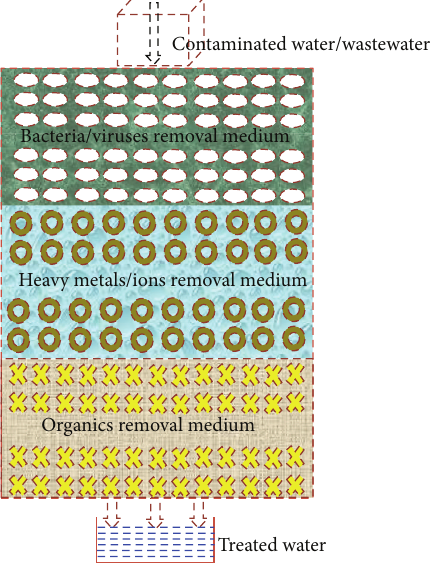
Figure 3: Schematic of a proposed composite nanofibrous media/membrane filters for complete removal of contaminants from